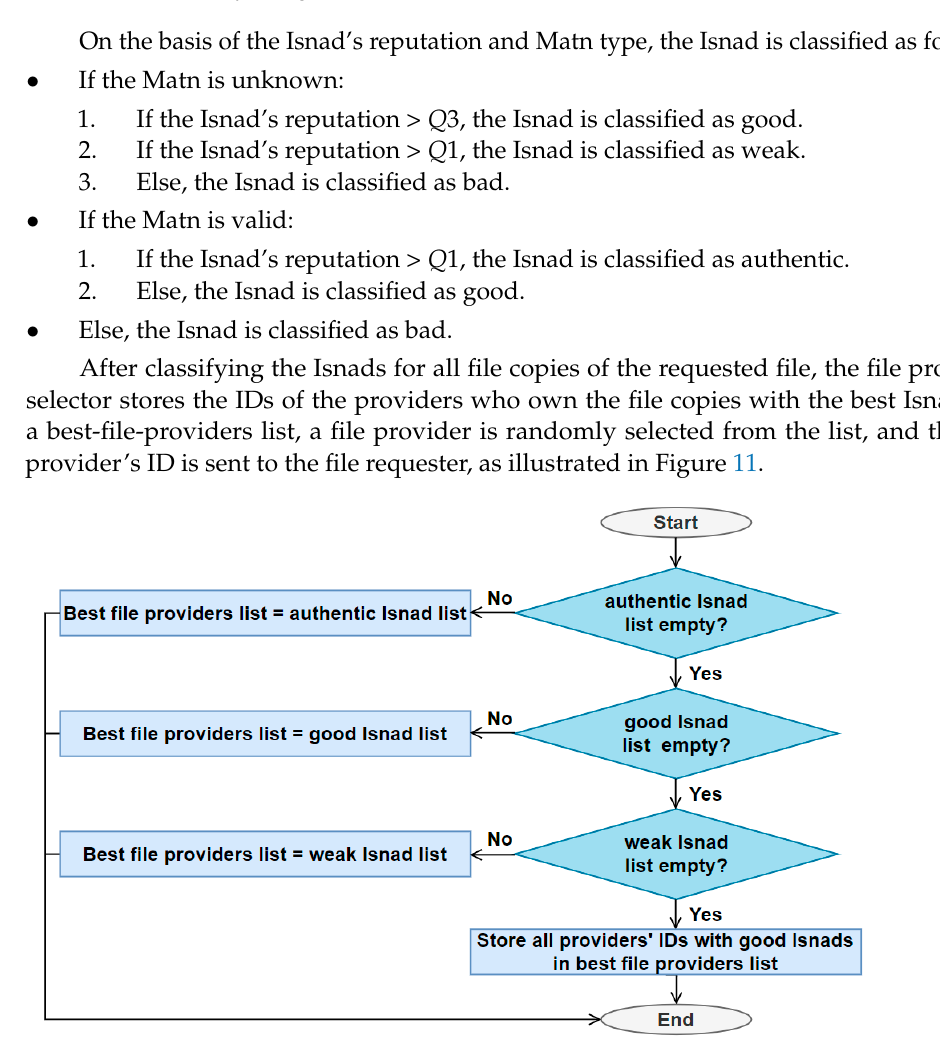
Figure 11. Best provider list selection flowchart.